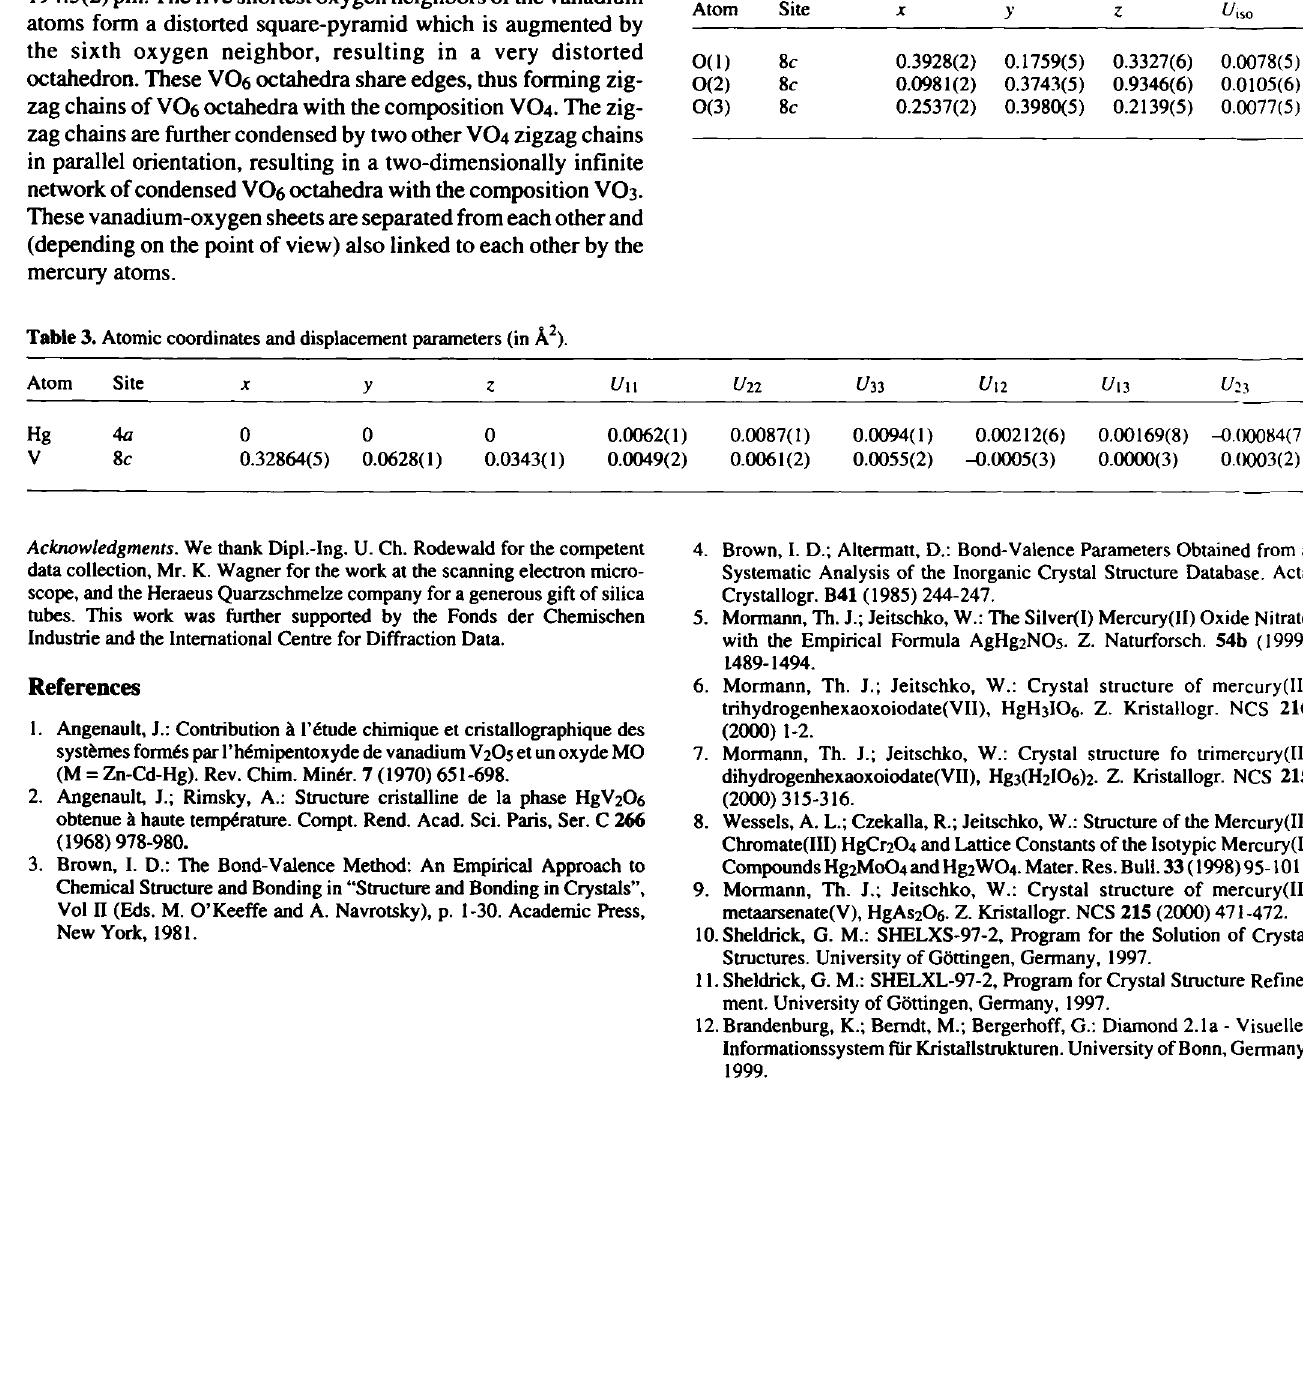
Table 2. Atomic coordinates and displacement parameters (in A 2 ).